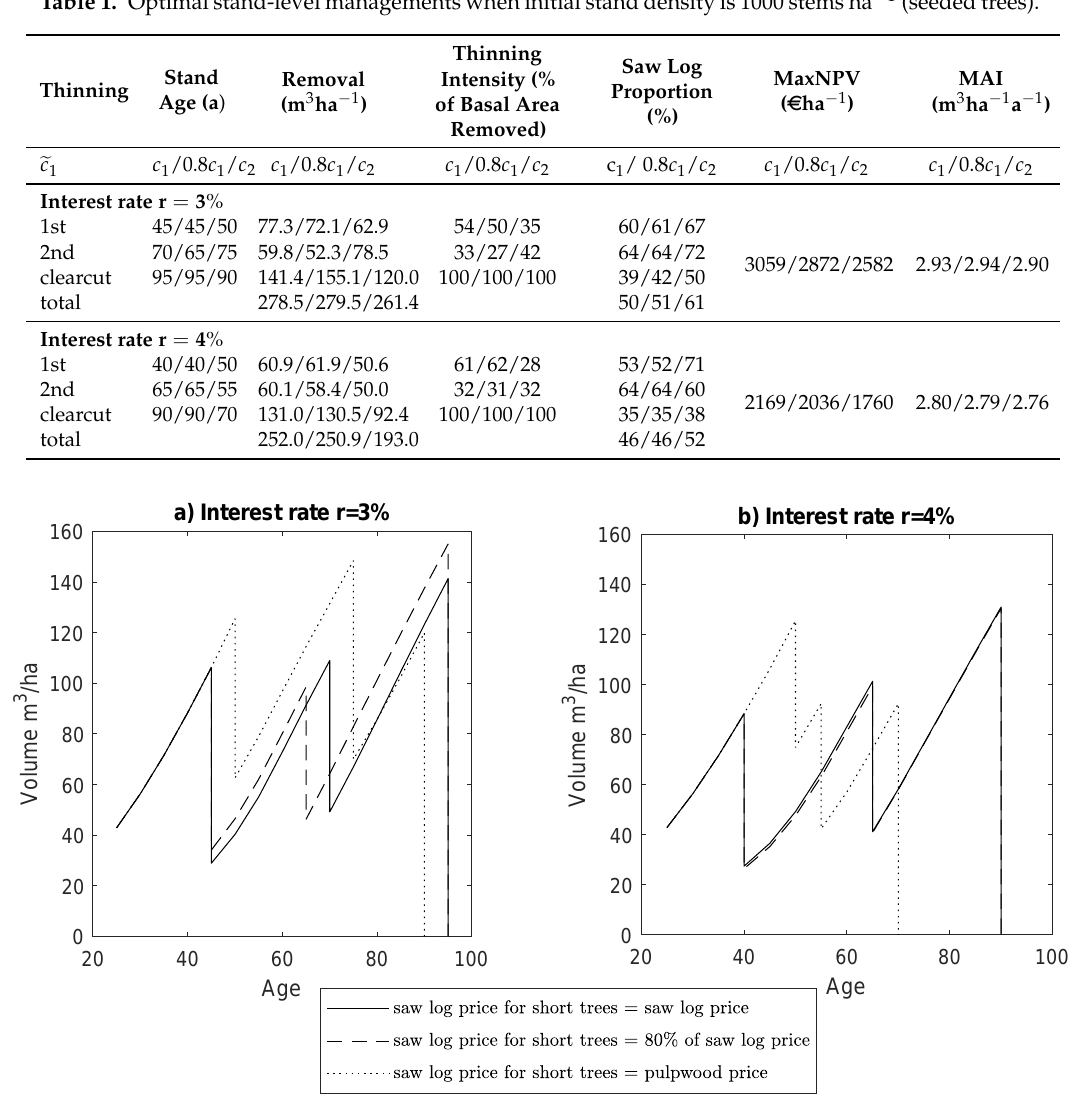
Figure 1. Volumes in stand managements with different saw logs pricing, m 3